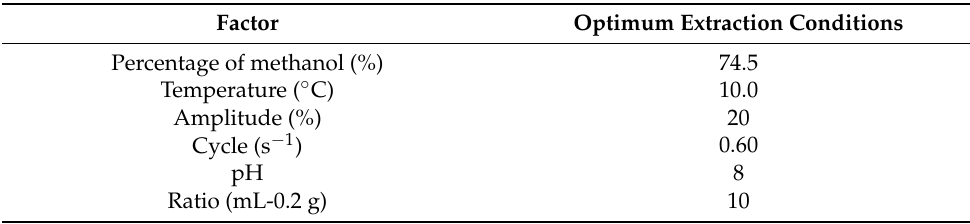
Table 4. Optimum extraction conditions for total flavonoids in methanolic extracts from moringa